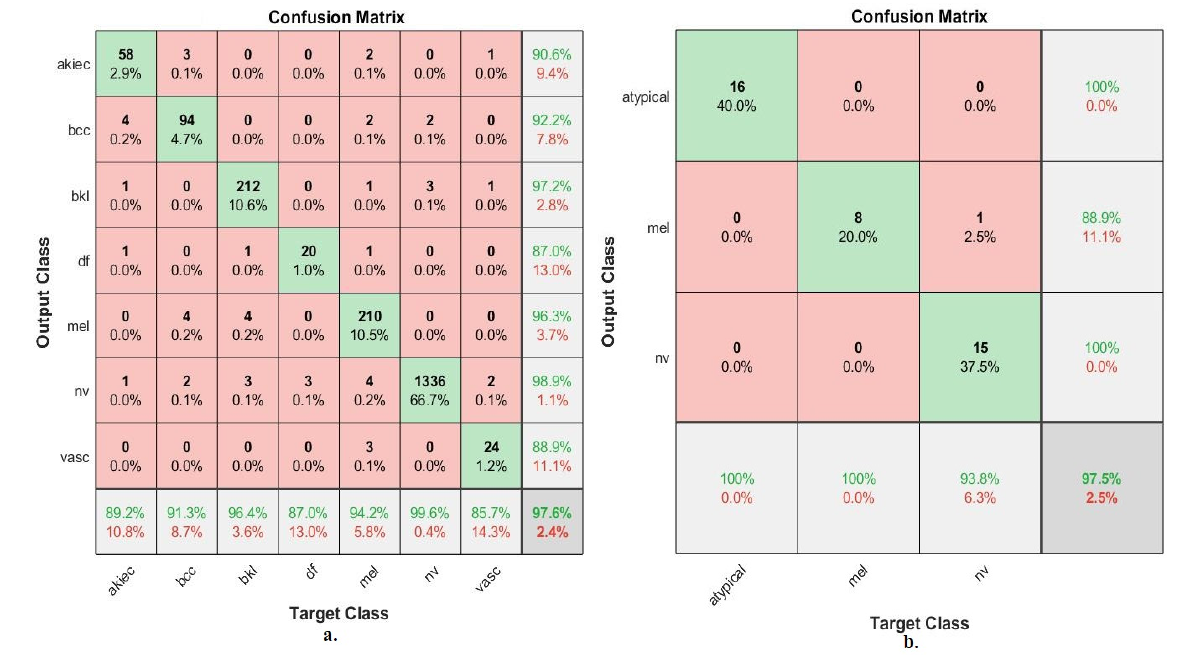
Figure 15. Confusion matrix for the classification of two skin lesion datasets by ANN with fused features of ResNet101 and handcrafted through datasets of ( a ) HAM10000 and ( b ). PH2.